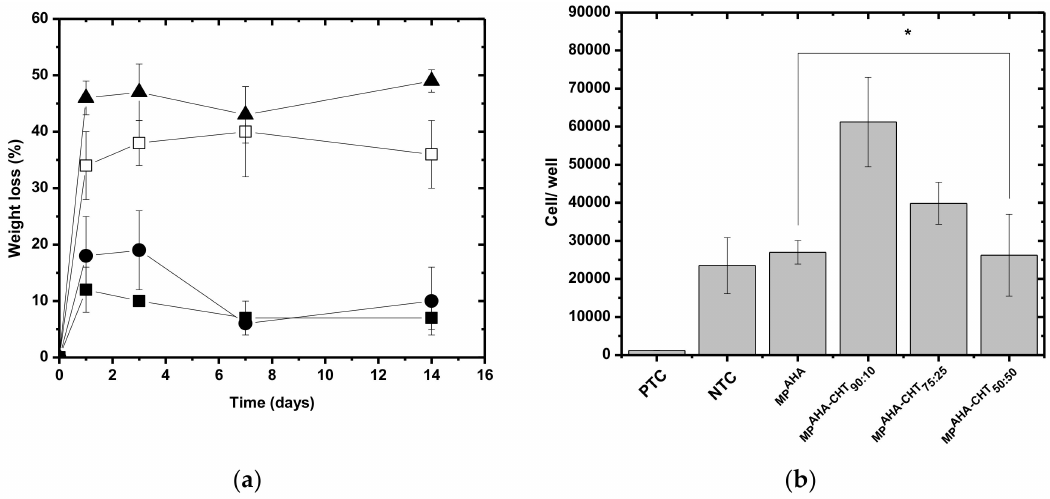
Figure 1. ( a ) The weight loss of the microparticles (MPs) as a function of the time of degradation (T = 37 ◦ C, PBS pH = 7.4). ( (cid:3) ) MP AHA, ( (cid:78) ) MP AHA-CHT 90:10 , ( (cid:8) ) MP AHA-CHT 75:25 , and ( (cid:4) ) MP AHA-CHT 50:50 . ( b ) Cytotoxicity expressed as viability of h-AdMSCs exposed to the MPs. Negative toxicity control (NTC) = DMEM with 10% FBS (fetal bovine serum), positive toxicity control (PTC) = DMEM with phenol 0.5%. Mean ± standard deviation n = 3. * The population means were significantly di ff erent from the positive control at p <